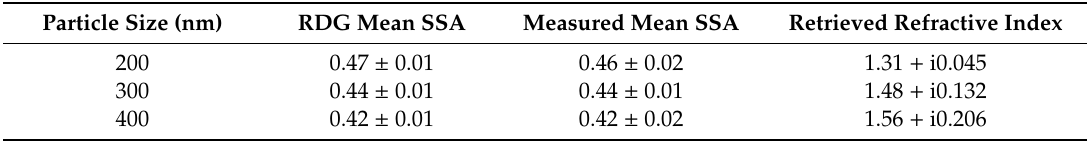
Table 2. Mean single scattering albedo (SSA) values from experimental and Rayleigh–Debye–Gans (RDG) calculations and retrieved refractive index for eucalyptus